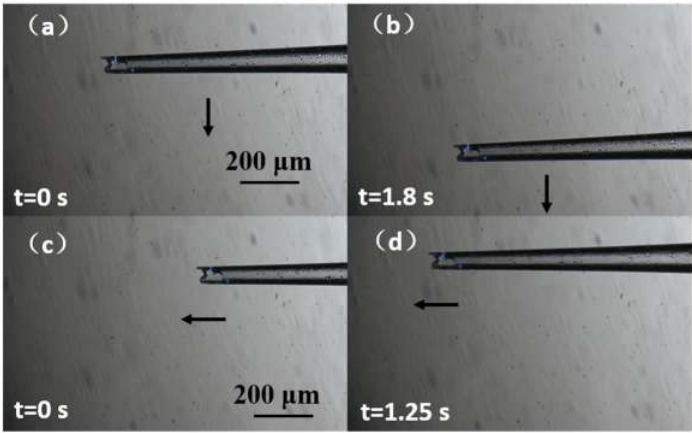
Figure 10. Millirobot motion along ( a , b ) the Y axis and ( c , d ) X axis.